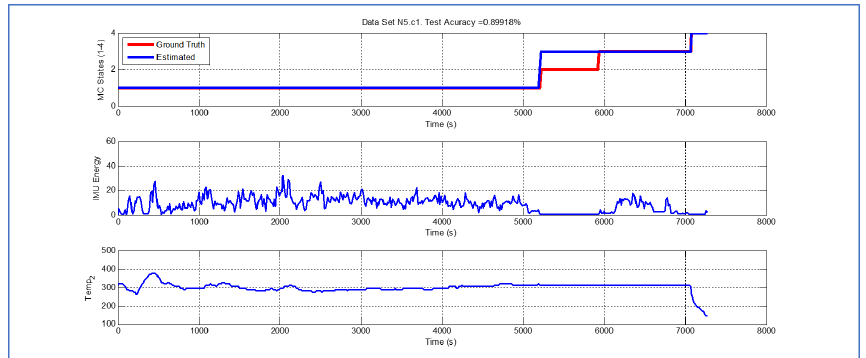
Figure 4. Detection of berry harvesting stages. dataset N 5 c 1